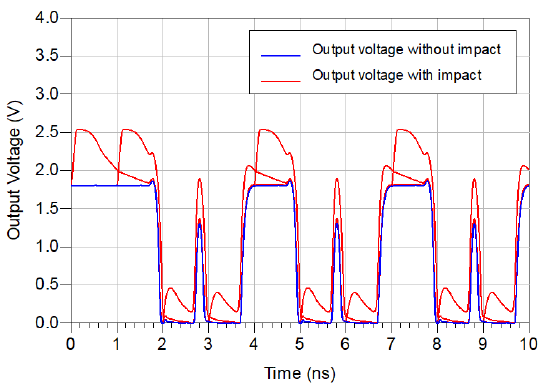
Figure 7. The blue signal is the output of the Programmable-FD without any impact and the red signal is when impacts were applied each